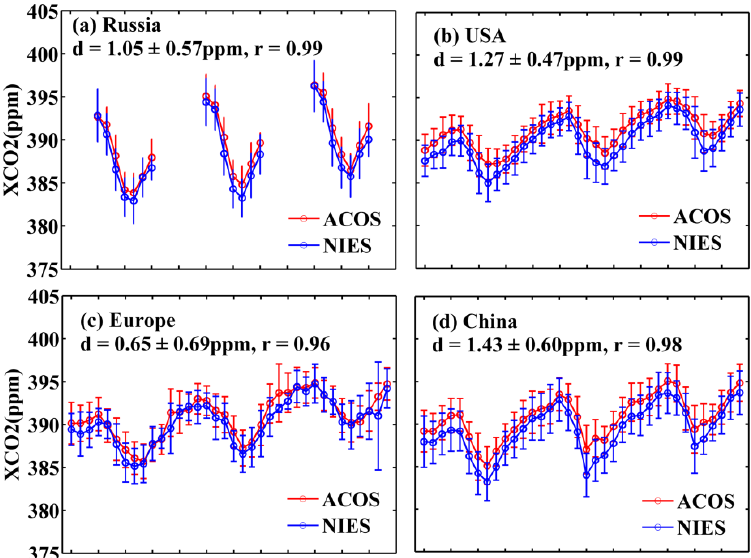
Figure 7. Cont. Figure 7. Cont.